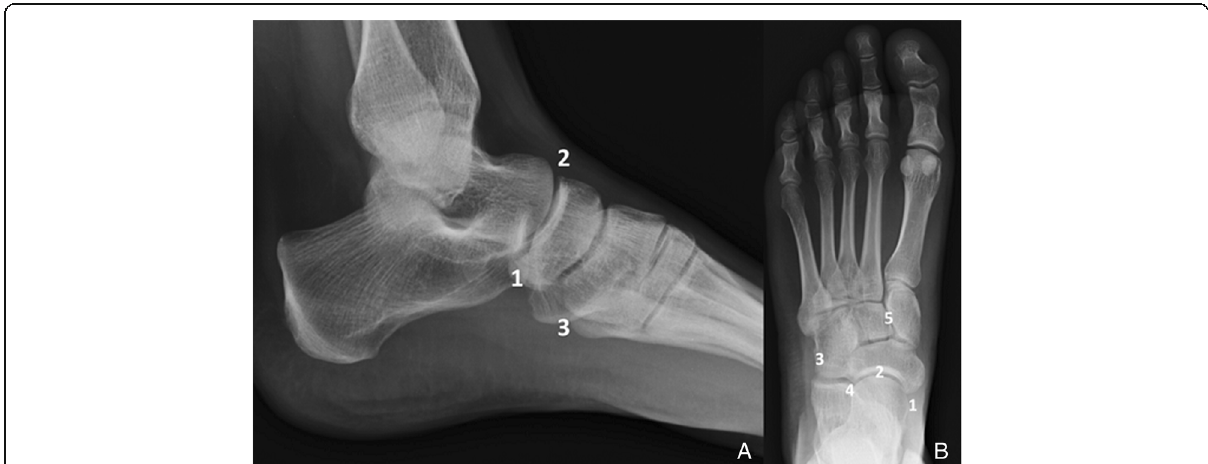
Fig. 1 Diagram of the location of the most common accessory bones of the midfoot. a Lateral and ( b ) AP projection of the midfoot. 1 — Accessory